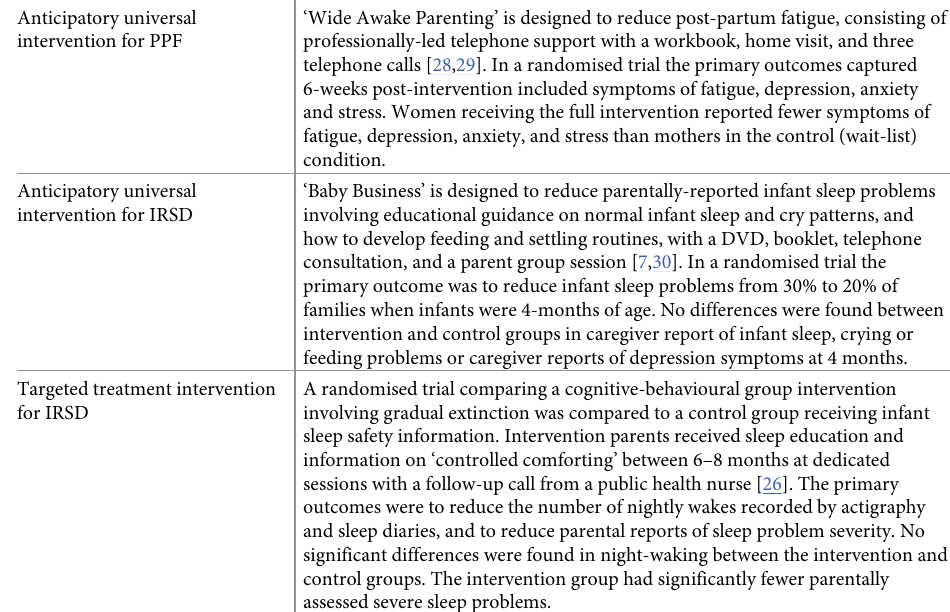
Table 1. Examples of intervention types for